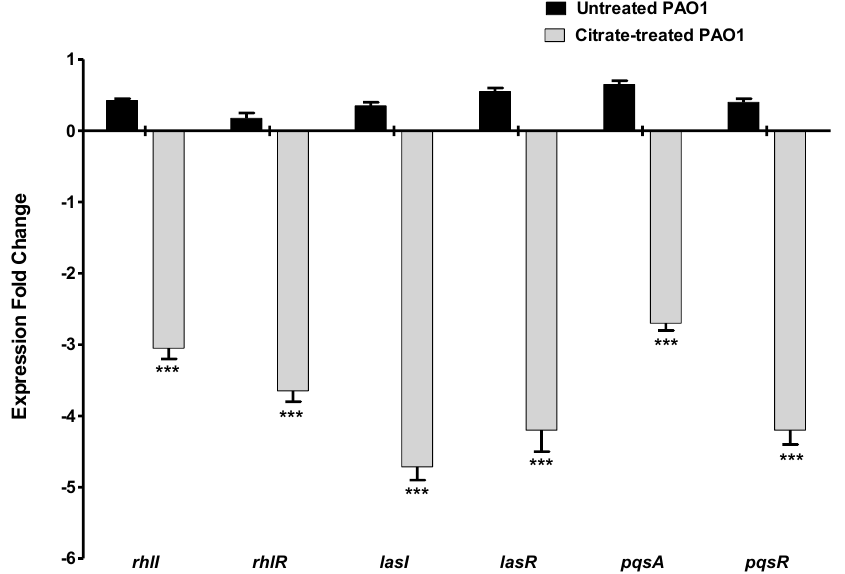
Figure 6. Sodium citrate downregulates the expression of QS-encoding genes. The expressions of the encoding genes of the autoinducer synthetase and receptors of the main three QS systems in P. aeruginosa were quantified using RT − PCR and normalized to the expression level of housekeeping gene ropD . Sodium citrate significantly decreased the expression of all QS-encoding genes (*** = p < 0.0001).